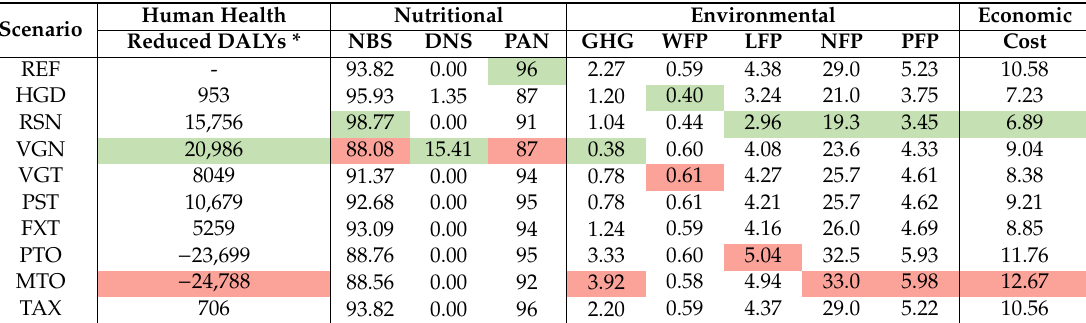
TAX Thescenariosareasfollows: currentSwissdiet(REF),HealthyGlobalDiet(HGD),dietfollowingtherecommendation of Swiss Society in Nutrition (RSN), Vegan diet (VGN), lacto-ovo Vegetarian diet (VGT), lacto-ovo Pescatarian